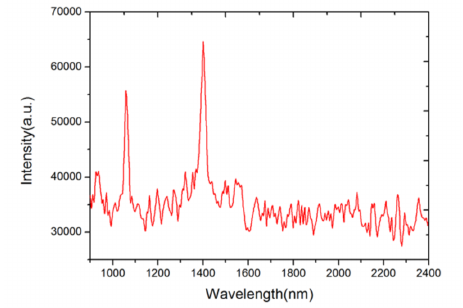
Figure 3. The typical spectral recorded of the pump and signal